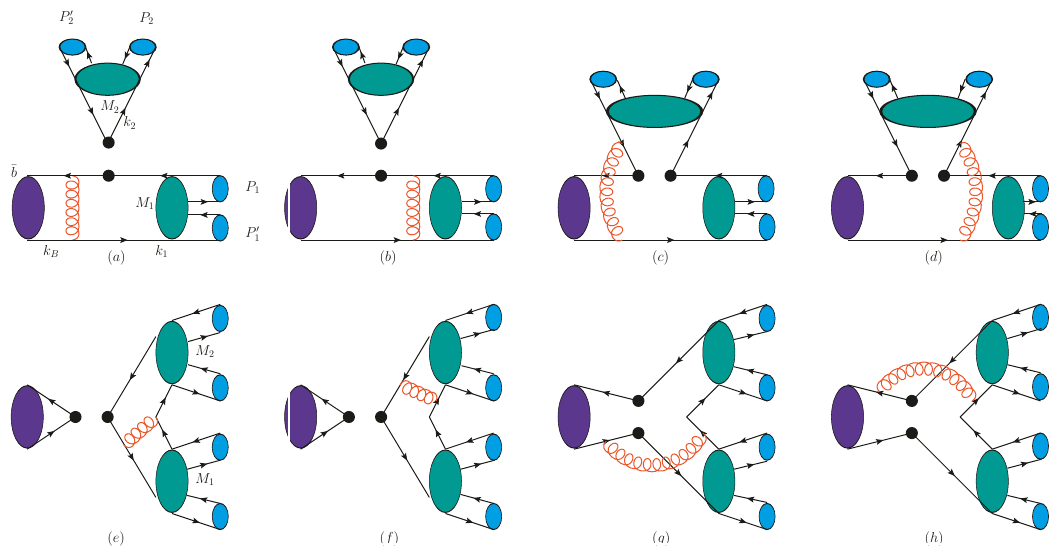
Figure 2 . Leading-order diagrams for the B → M 1 M 2 → P 1 P 0 denotes a weak vertex, and the cyan oval represents either a scalar or vector